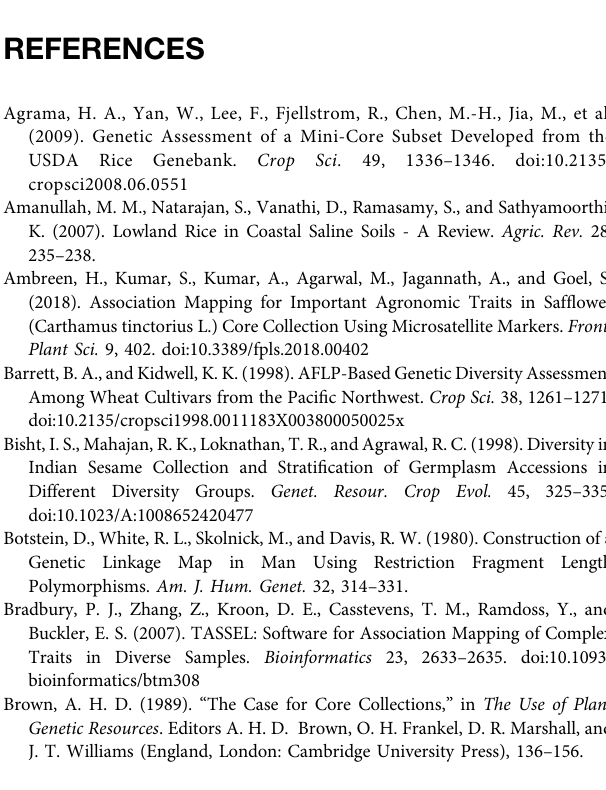
Supplementary Figure S21 | Estimation of population using LnP(D) derived Δ k for k from 2 to10 of Tamil Nadu rice collection Supplementary Figure S22 | Bar plot of population structure of Tamil Nadu rice collection Supplementary Figure S23 | Scattered plot (PCoA) of total east coast rice accessions (2242) (among 4 populations) Supplementary Figure S24 | Scattered plot (PCoA) of total east coast rice accessions (2242) (among 19 sub populations) Supplementary Figure S25 | Pie chart showing percentage of molecular variance of rice collection of Andhra Pradesh Supplementary Figure S26 | Scattered plot (PCoA) of rice collection of Andhra Pradesh Supplementary Figure S27 | Pie chart showing percentage of molecular variance of rice collection of Orissa Supplementary Figure S28 | Scattered plot (PCoA) of rice collection of Orissa Supplementary fi gure S29 | Pie chart showing percentage of molecular variance of rice collection of Tamil Nadu Supplementary Figure S30 | Scattered plot (PCoA) of rice collection of Tamil Nadu SupplementaryFigureS31| VennDiagramshowingthedistribution ofaccessions in the east coast core and the mini-core collection Supplementary Figure S32 | Pie chart showing percentage of molecular variance of the east coast rice core set (247) Supplementary Figure S33 | Scatteredplot(PCoA)oftheeastcoastricecoreset(247) Supplementary Figure S34 | Histogram showing the kinship status of rice accessions in the east coast core collection Supplementary Figure S35 | Comparative analysis of heterozygosity and major allele frequency values across eat coast rice and north-east rice